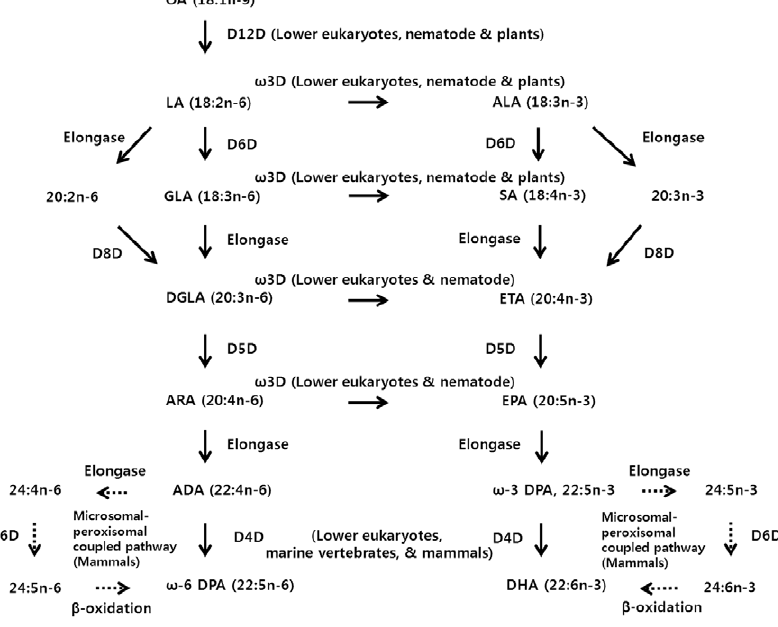
Figure 1. PUFA synthetic pathway to 22-carbon fatty acids from oleic acid in eukaryotic